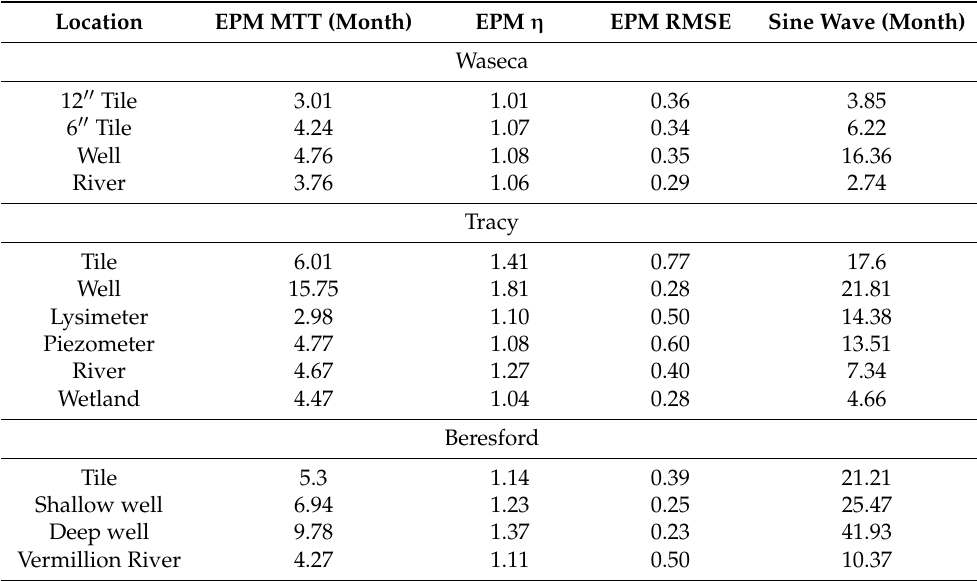
Table 5. Water mean transit time at each